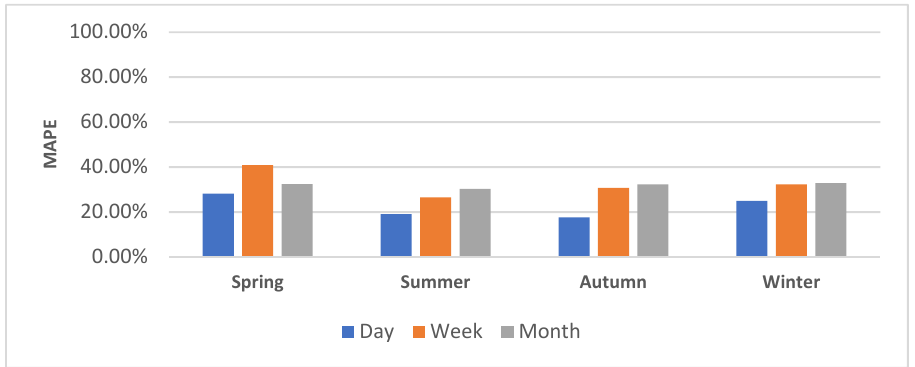
Figure 10. A comparison of month PR predictions’ MAPE.